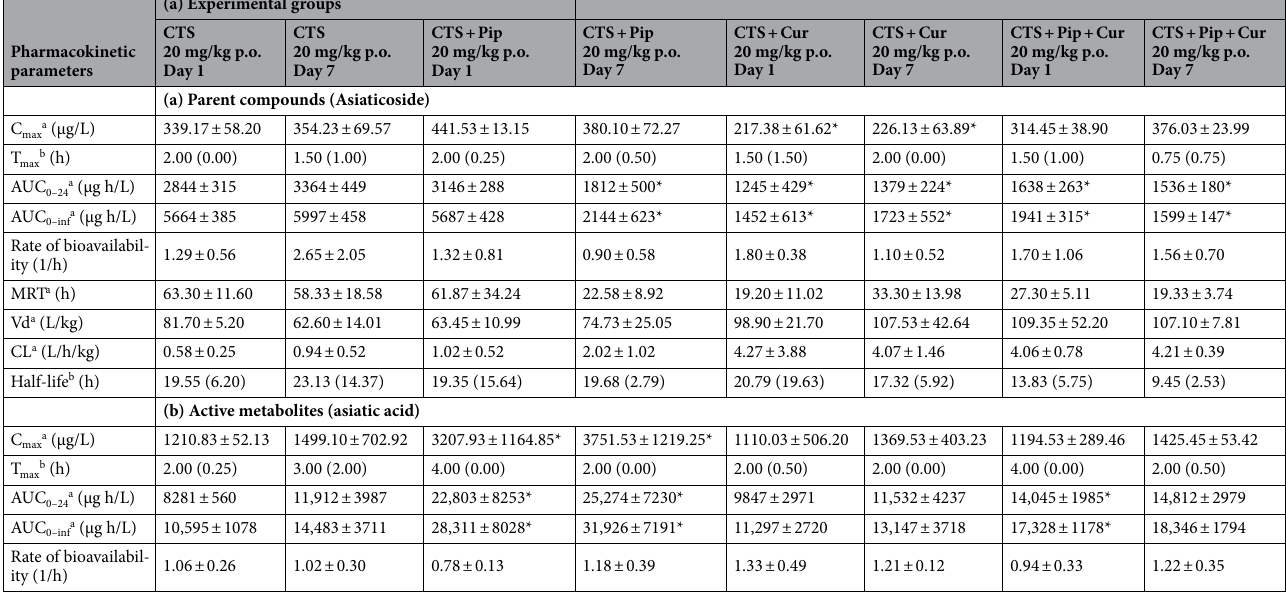
Table 3. Pharmacokinetic parameters of asiaticoside (a) and asiatic acid (b) after oral administration of 20 mg/kg Centell-S, 20 mg/kg Centell-S + 20 mg/kg piperine, 20 mg/kg Centell-S + 20 mg/kg